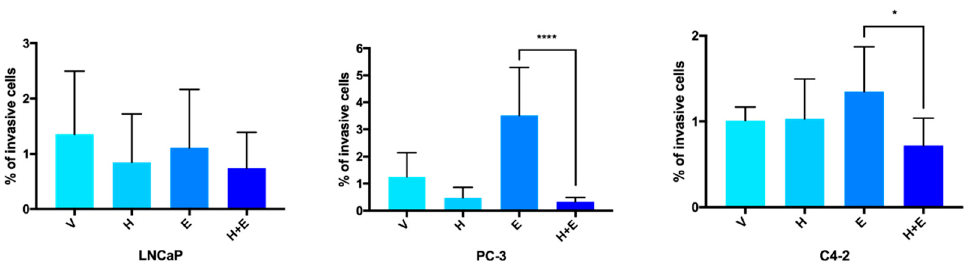
Figure 8. The combined treatment of hydralazine and enzalutamide downregulated the invasion cancer) cell lines. Values were normalized to the vehicle condition. (V—vehicle, H—hydralazine, E—enzalutamide, potential of PCa (prostate cancer) cell lines. Values were normalized to the vehicle condition. (V— vehicle, H—hydralazine, E—enzalutamide, H+E—combination of hydralazine and enzalutamide). H+E—combination of hydralazine and